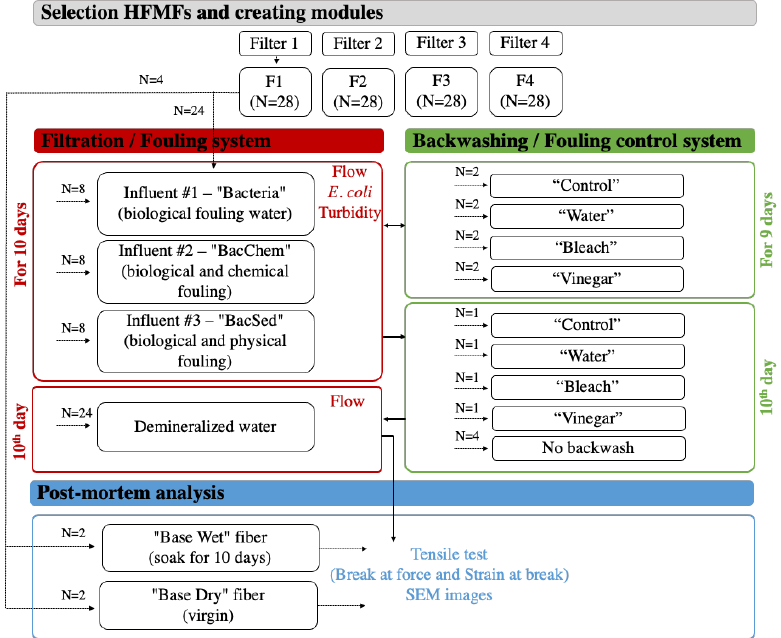
Figure 1. Experimental design. The filtration/backwash cycle was repeated for nine consecutive days. On the tenth day, filtration was performed, but only one module of each pair was backwashed after filtration. The other module from each pair was used as no-backwash control to assess the impact of the final study-end backwash. Finally, all modules were run with demineralized water and proceeded to postmortem analysis.